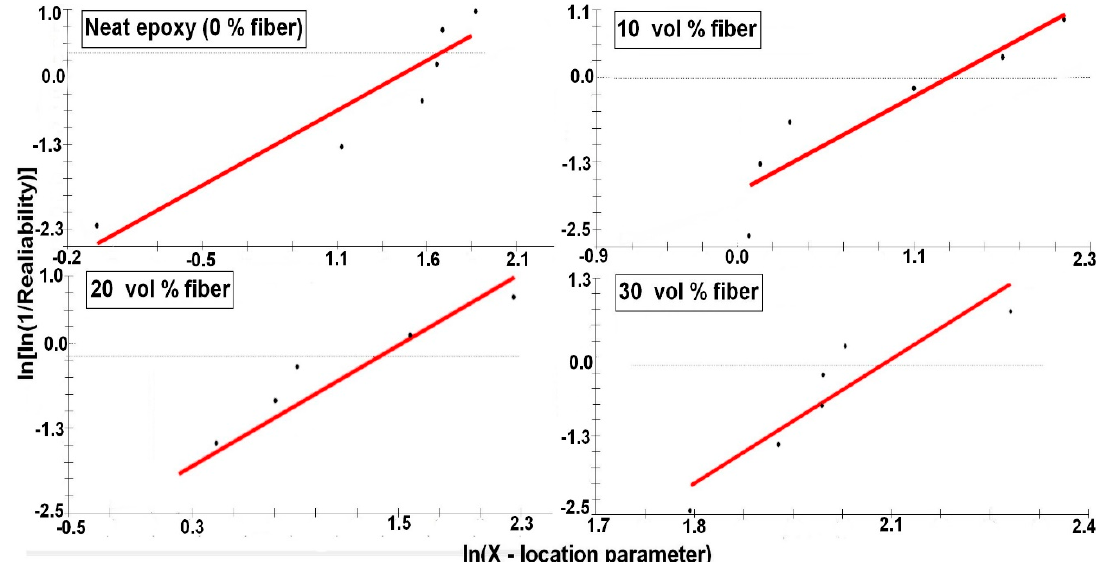
Figure 6. Typical broken specimens of the caranan fiber epoxy composite after the tensile test.